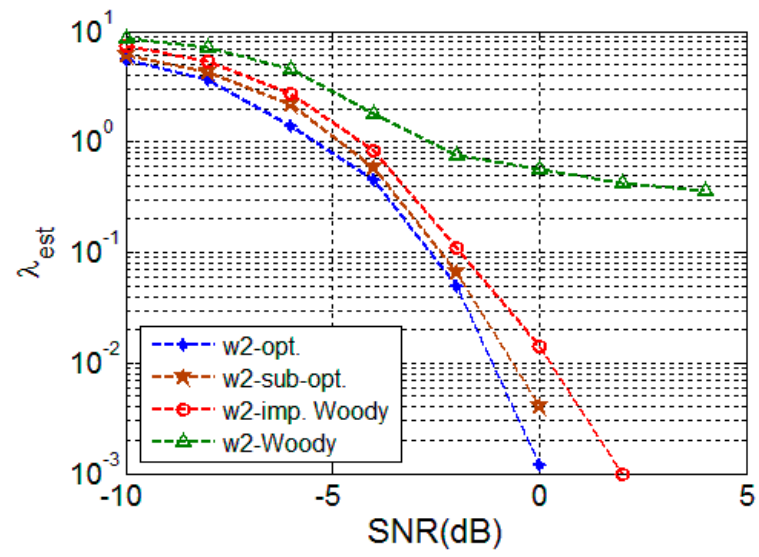
Figure 4. TDE performance for colored random signal (w2).